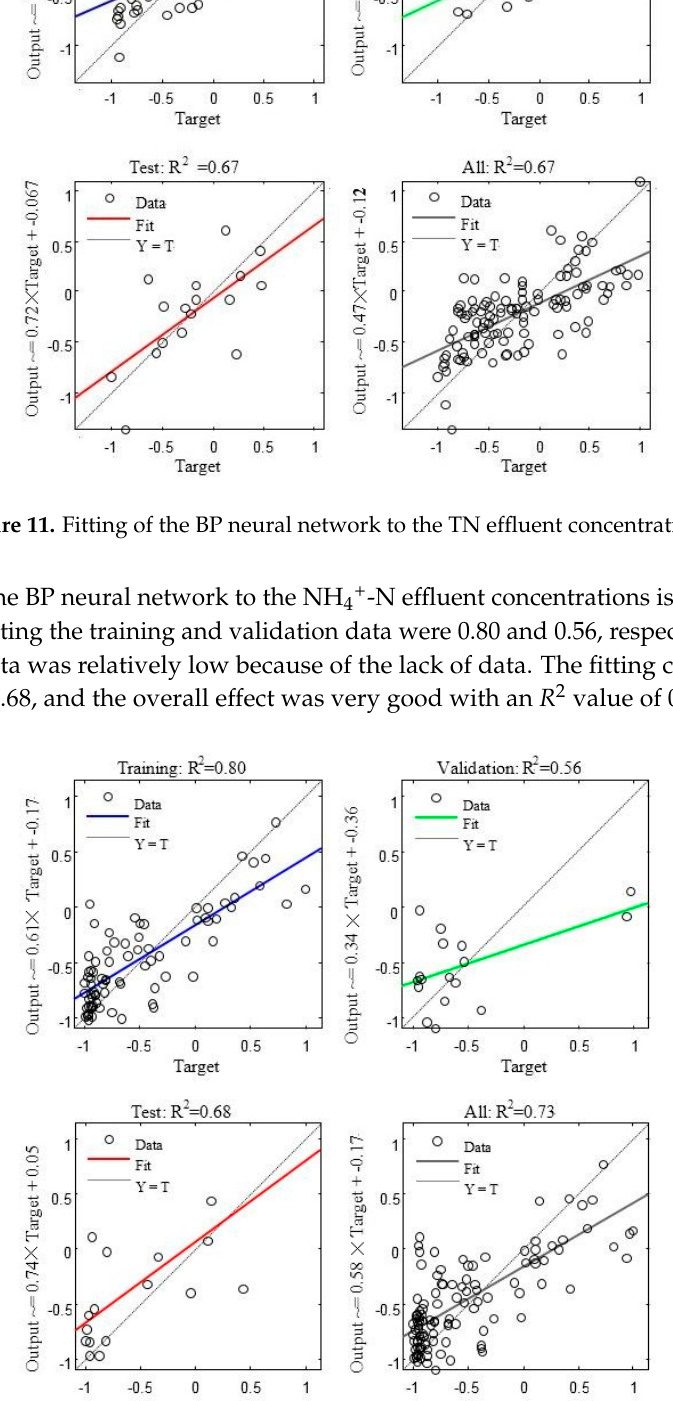
Figure 12. Fitting of the BP neural network to the NH 4+ -N effluent concentrations.